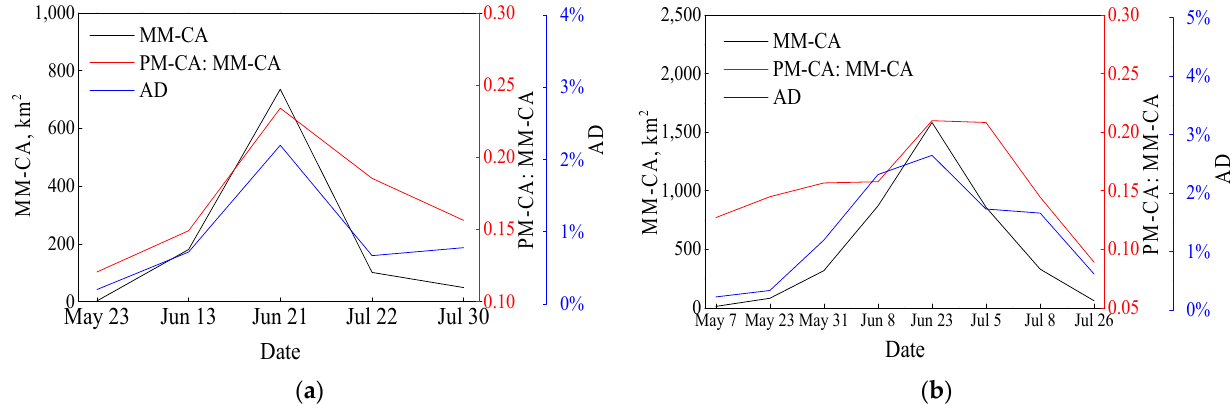
Figure 7. Changes of MM-CA, PM-CA: MM-CA and AD of macroalgae derived from GF-1 WFV images in 2018 ( a ) and 2019 ( b ), respectively.